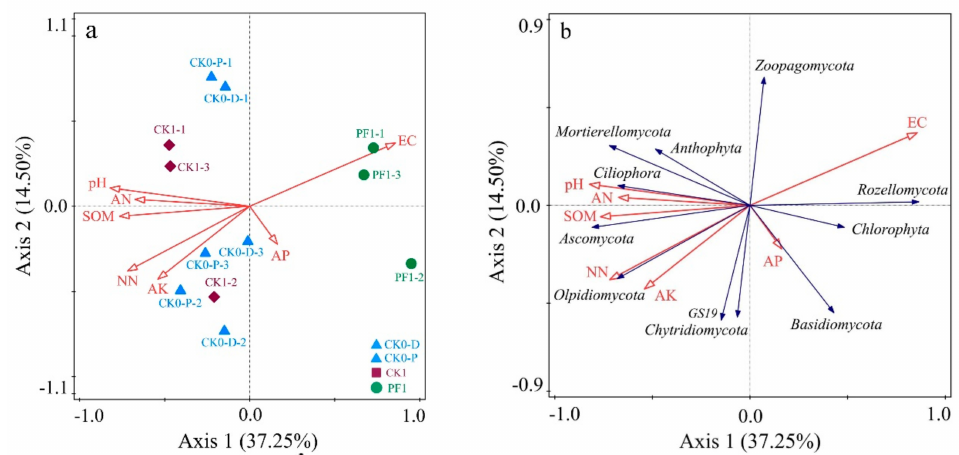
Figure 6. RDA of soil fungal community structure and soil environmental factors: ( a ) soil samples and the environmental factors; ( b ) chief fungal phyla and the environmental